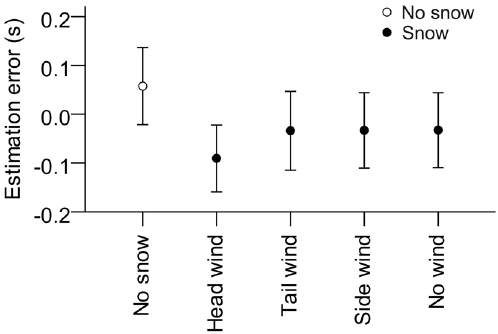
Figure 9. Mean TTC estimation errors (estimated TTC—actual TTC) as a function of snow condition. Error bars represent ± 1 standard error of the mean across participants.